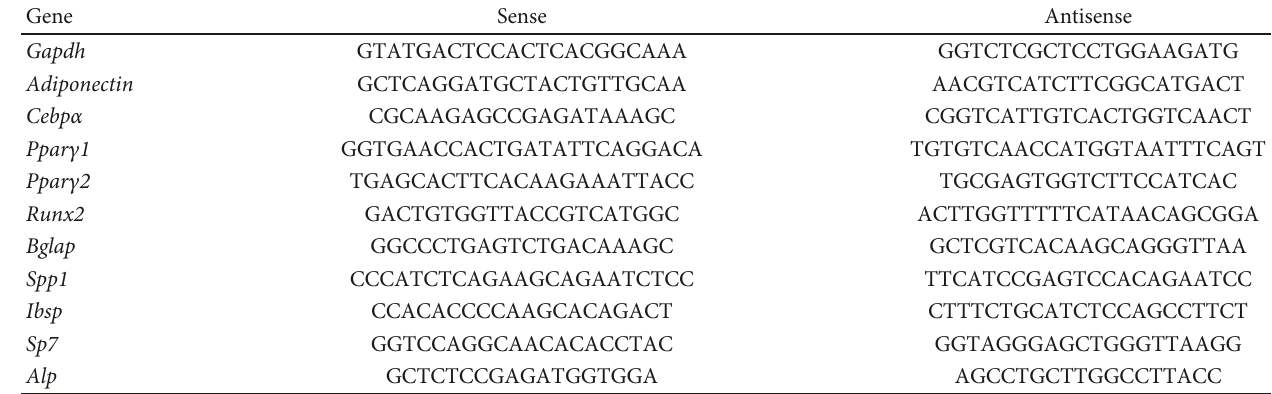
Table 1: Primer sequences for reverse transcript quantitative PCR